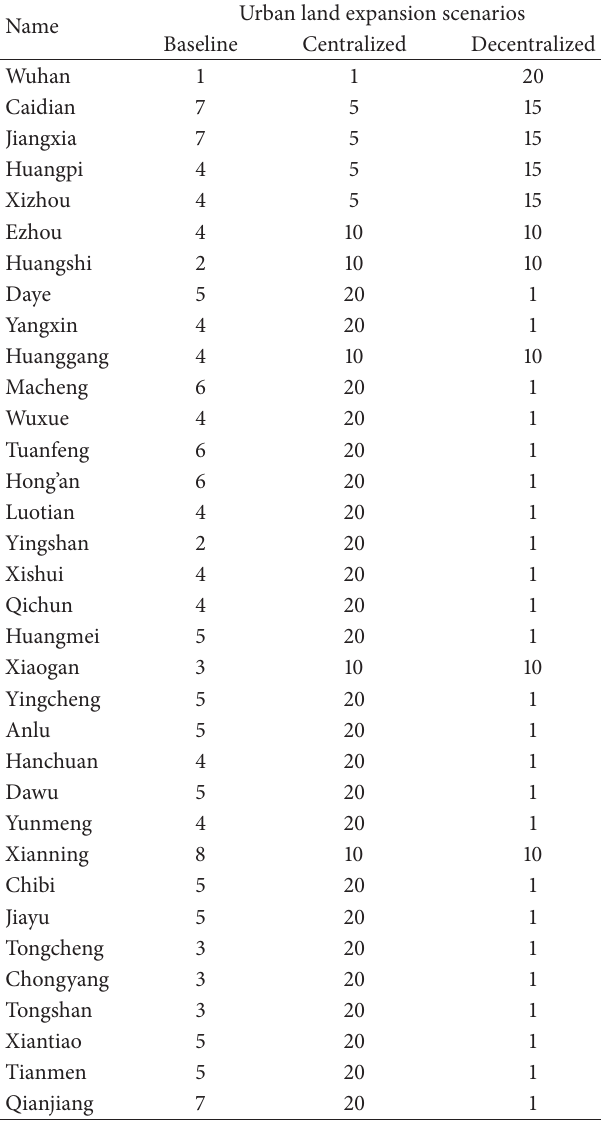
Table 1: Asynchronous evolution interval of urban land expansion in Wuhan Metropolitan under different